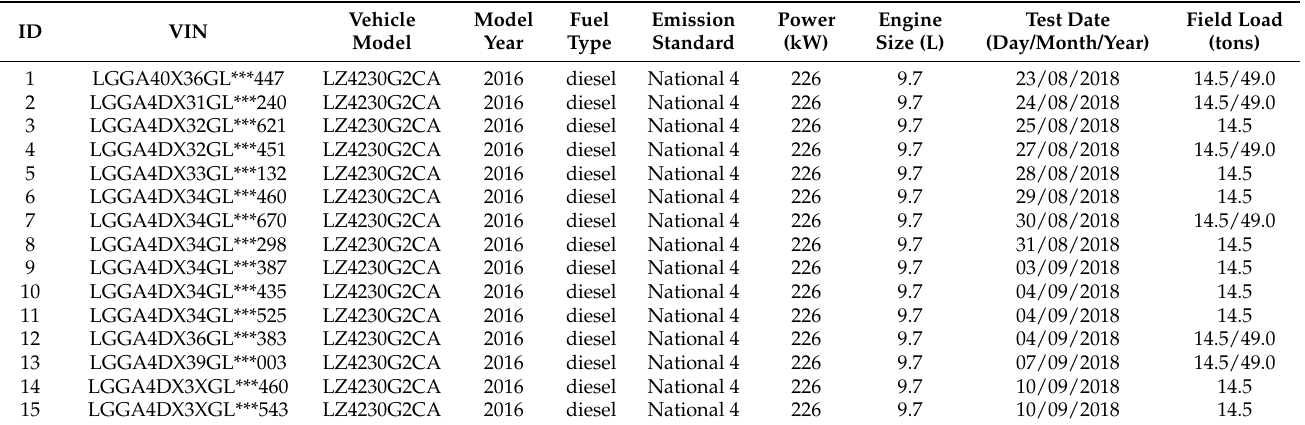
Table 2. The parameters of DSTTTs for emission data